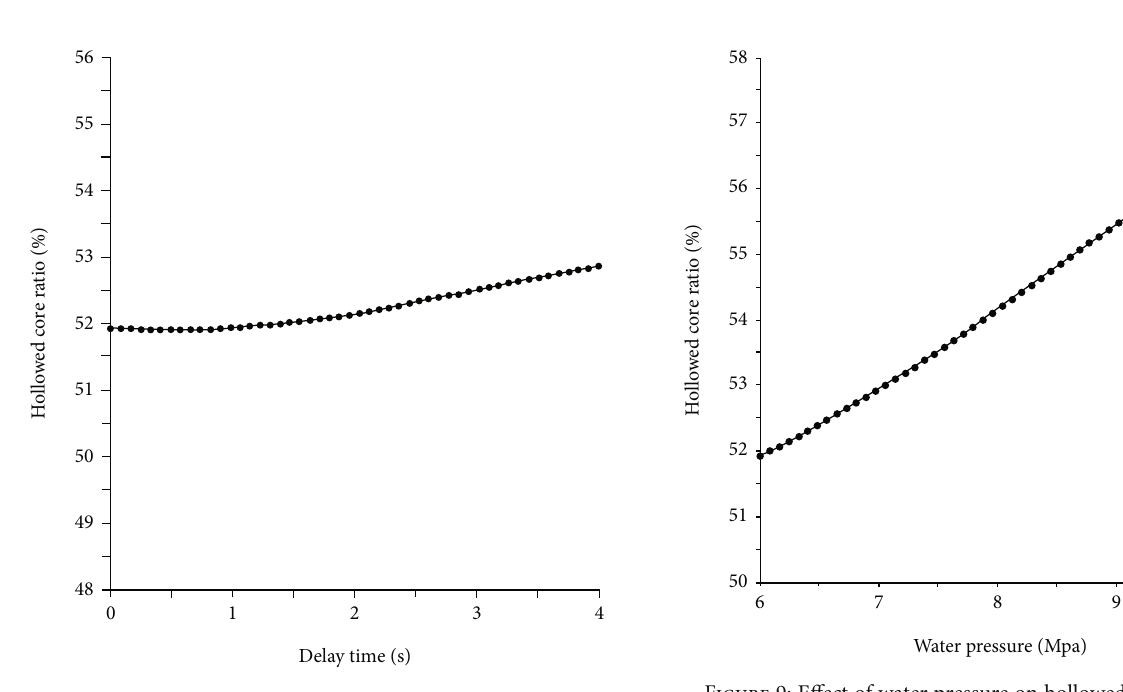
Figure 7: E ff ect of delay time on hollowed core ratio.